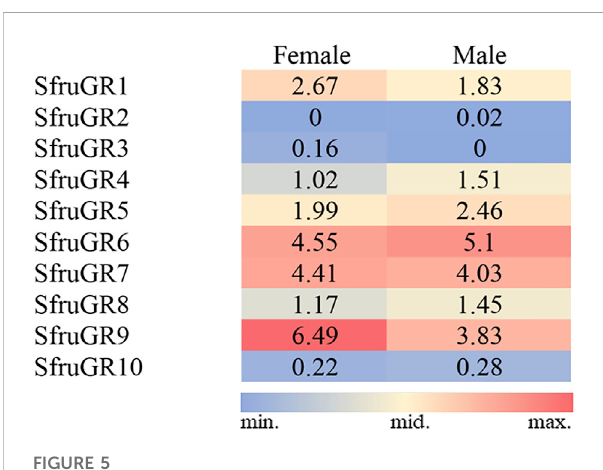
FIGURE 5 TPMvaluesofcandidateSfruGRsinthetarsiofmaleandfemale S . frugiperda